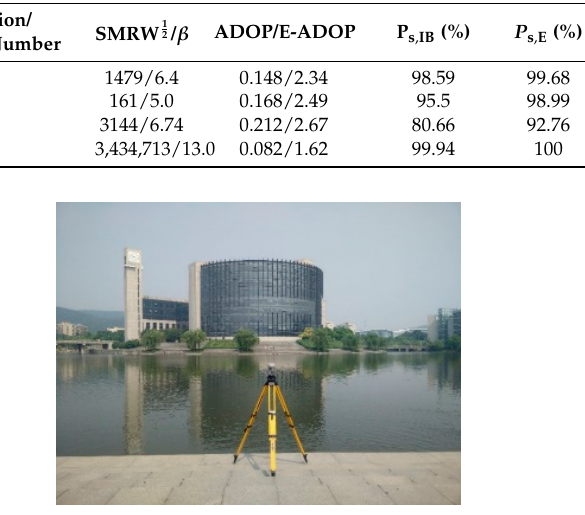
Figure 22. Multipath effect experimental setup.